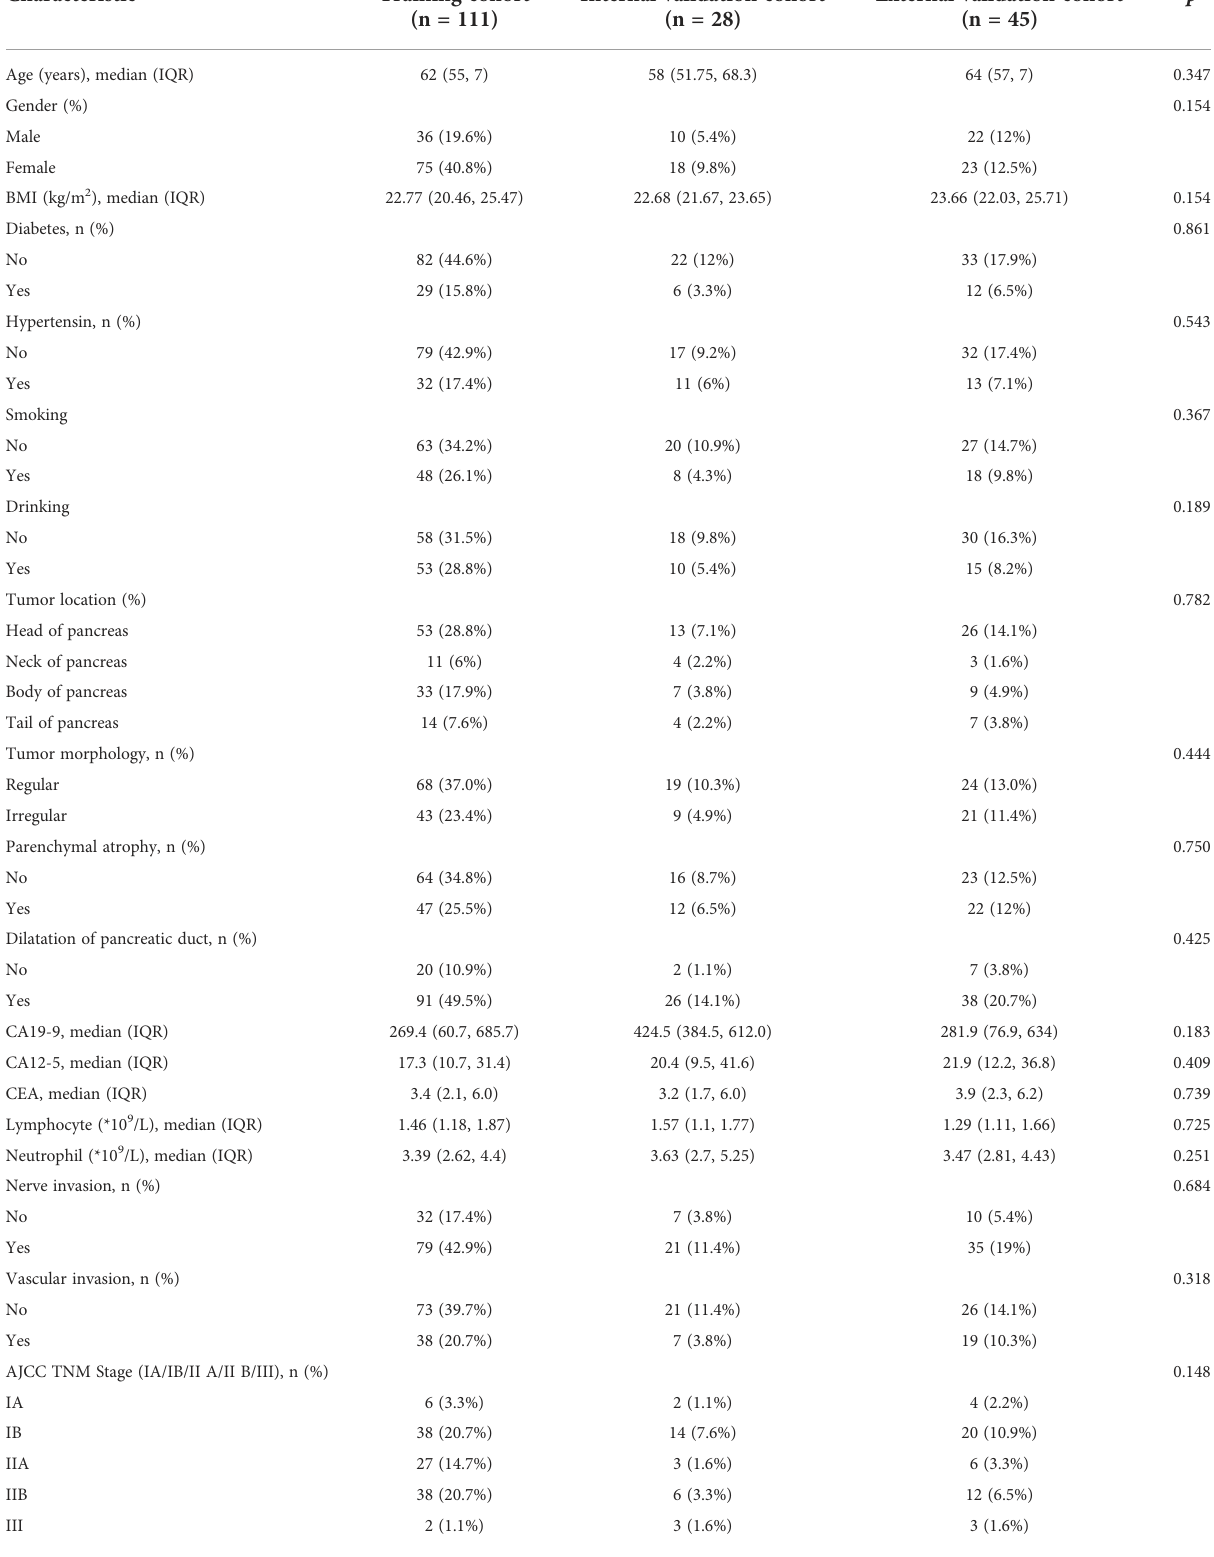
TABLE 1 Baseline parameters compared between the training, internal validation and external validation